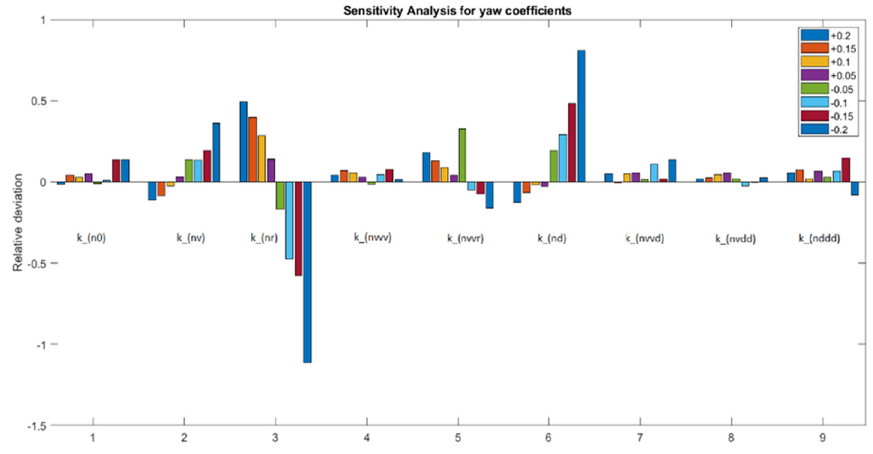
Figure 17. Sensitivity analysis for yaw coefficients.